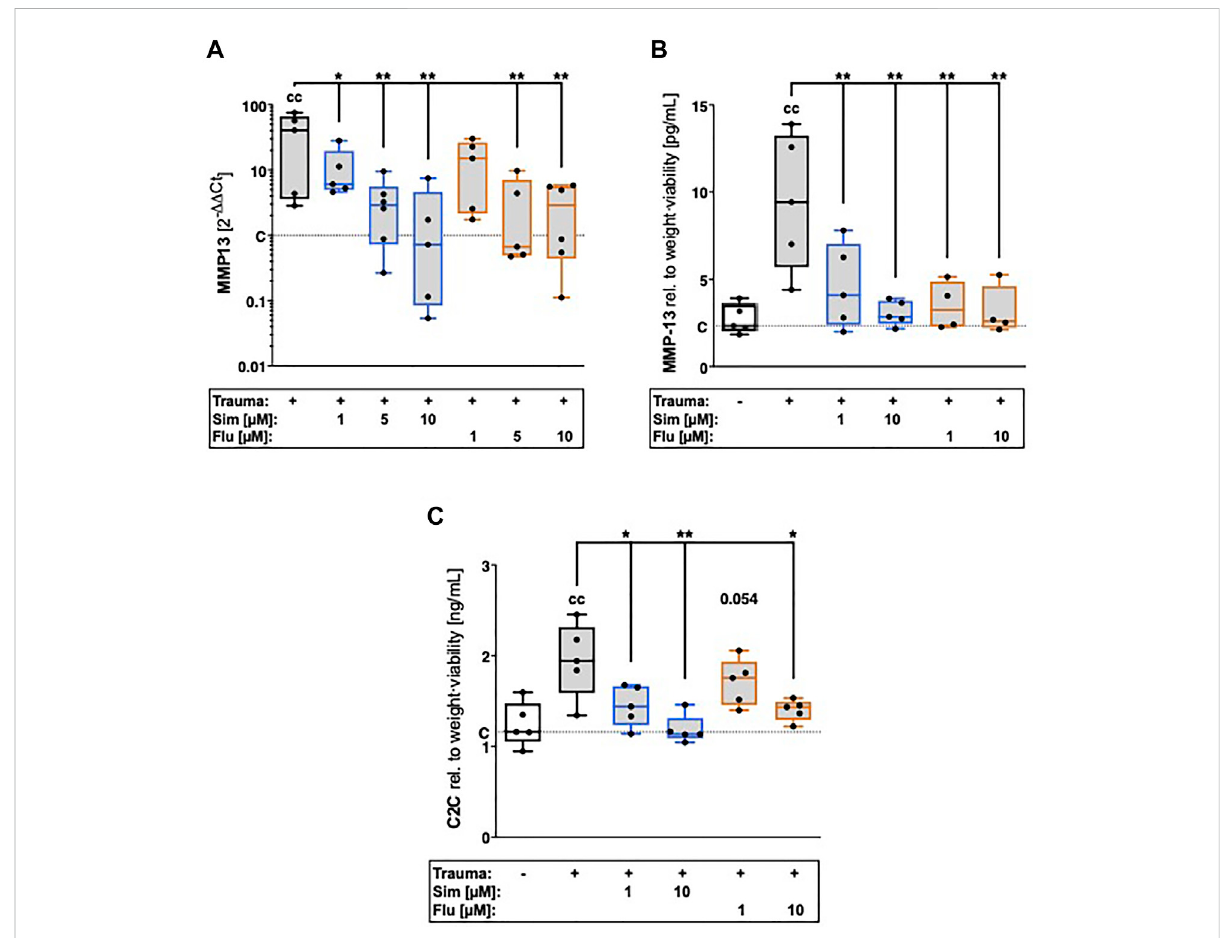
FIGURE 2 Effects of statin treatment on trauma-induced expression of catabolic enzymes and collagen type II breakdown. Catabolic processes were assessed by means of gene expression analysis of (A) MMP13 as well as (B) quanti fi cation of MMP-13 release and (C) collagen type II breakdown productC2C.Signi fi cantdifferencesbetweengroupsweredepictedas[versusT]*= p < 0.05,**= p < 0.01[versusC]c= p < 0.05,cc= p < 0.01; n ≥ 4. Blank box = unimpacted control (C), shaded boxes = traumatized cartilage explants